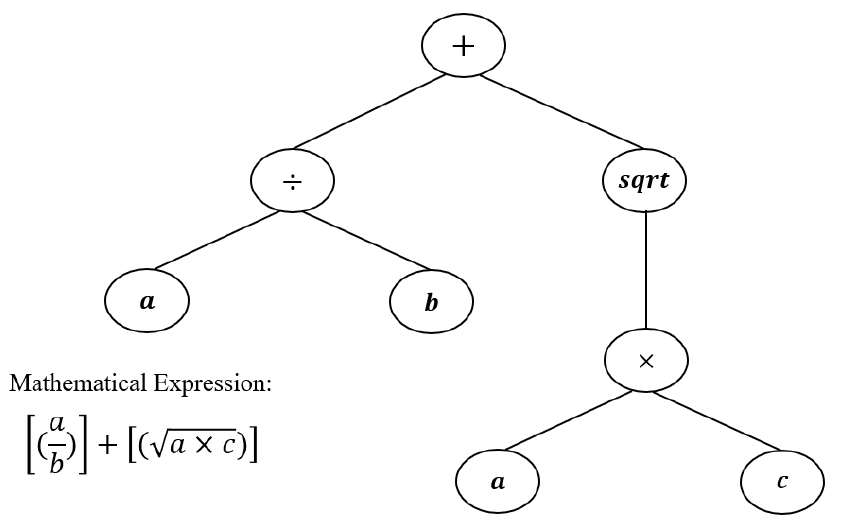
Figure 2. A typical two-gene chromosome with its corresponding mathematical expression (Modified after Gharagheizi et al. [46] ).